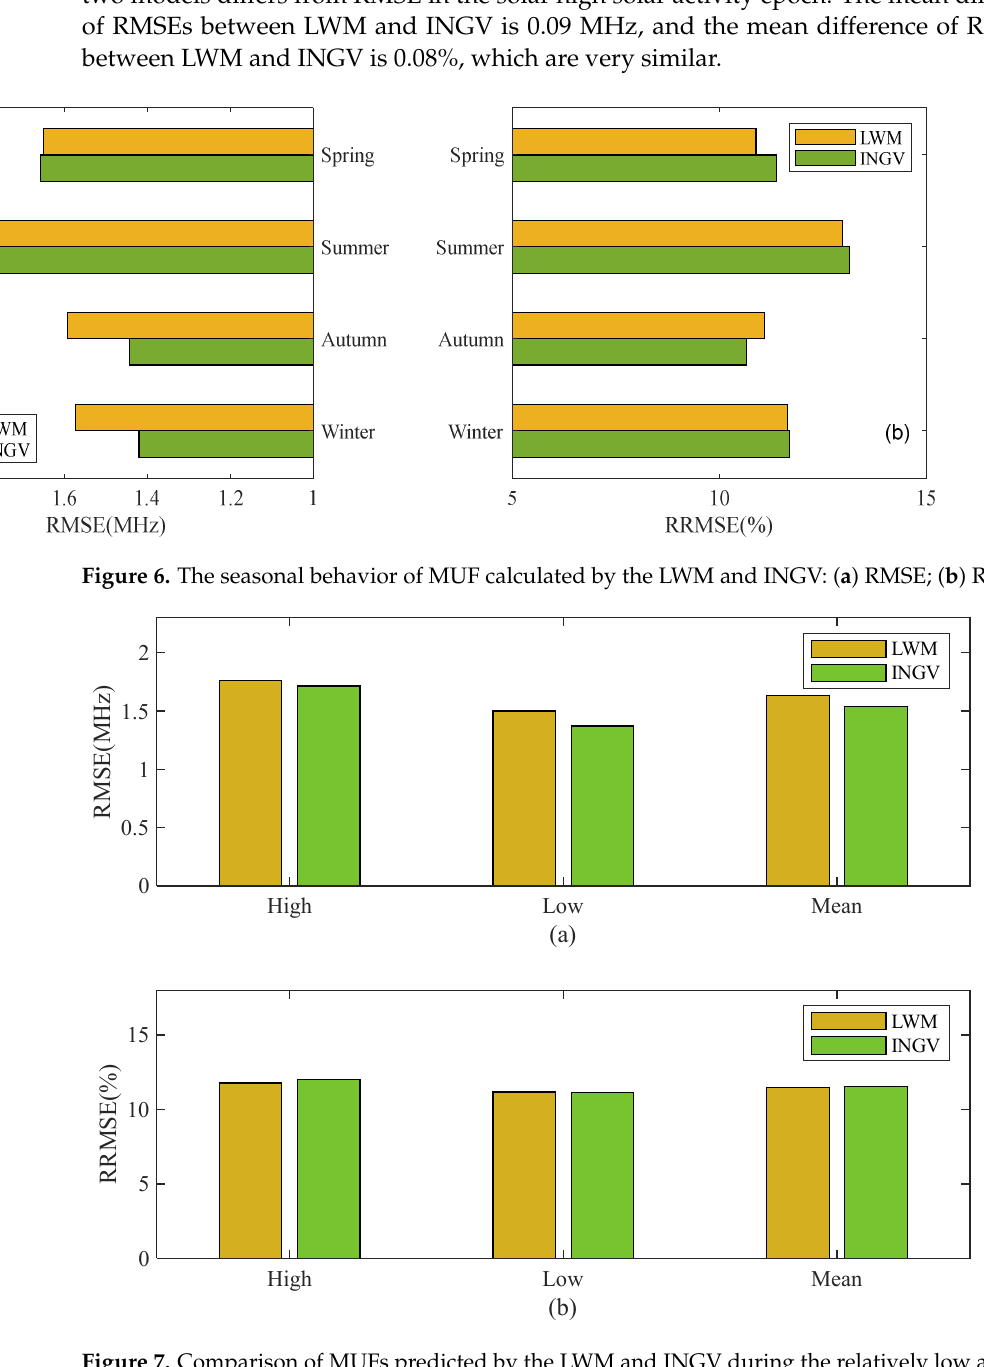
Figure 5. The prediction error of MUF during the different periods of sunrise, daytime, sunset, and nighttime: ( a ) RMSE, ( b ) RRMSE.